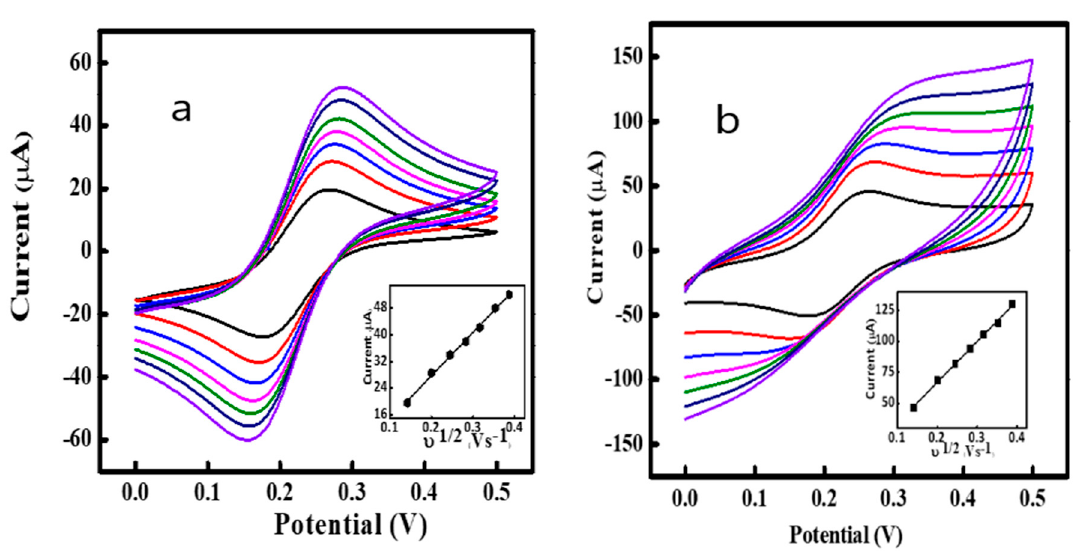
Figure 5. Cyclic voltammograms of ( a ) bare and ( b ) PANI modified Au disc electrodes, recorded in 4 mM K 3 Fe(CN) 6 / 1 M KNO 3 at di ff erent scan rates (20–150 mVs − 1 ). Inset: Dependence of anodic peak current on square root of scan rate.